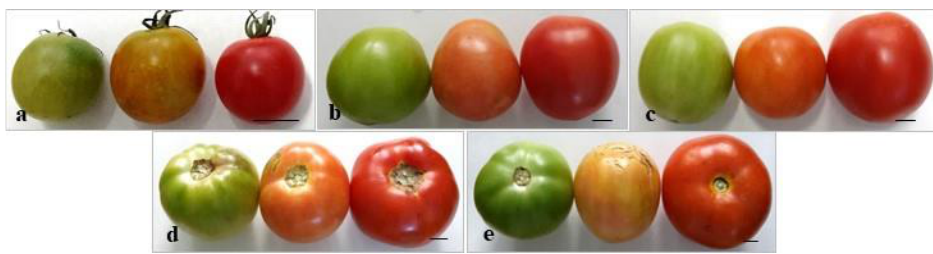
Figure 1. Tomato genotypes used for initiation of in vitro cultures starting from seeds. ( a ) cv. ‘Ca- priciu’; ( b ) cv. ‘Darsirius’; ( c ); cv. ‘Kristin’; ( d ) cv. ‘Pontica’; ( e ) cv. ‘Siriana’. Size bars = 1.0